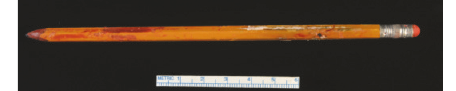
Figure 2: The pencil cystoscopically extracted in the operating